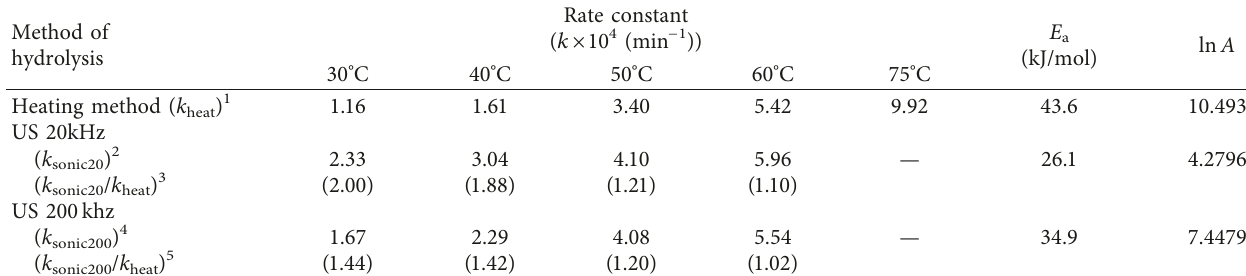
Table 2: The kinetics parameters of c -oryzanol hydrolysis obtained by the heating method and the homogeneous system of Type A with assistance of ultrasonic irradiation.